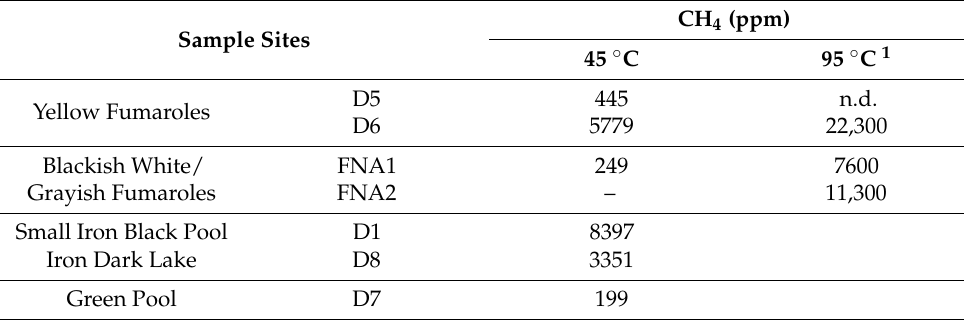
Table 2. Methane production in the microcosms incubated at 45 and 95 ◦